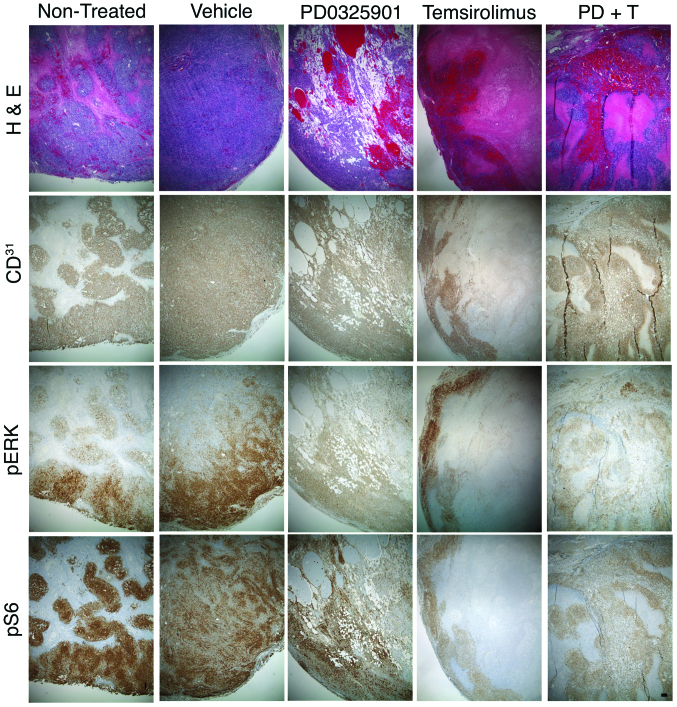
Treatment with PD0325901 and temsirolimus inhibits tumor cell signaling. Subcutaneous tumorgrafts of cardiac canine AS non-treated or treated with vehicle, PD0325901, temsirolimus, or PD0325901 plus temsirolimus (PD+T) were stained for H&E and immunostained for CD31, pERK and pS6. Bar, 100 μm.